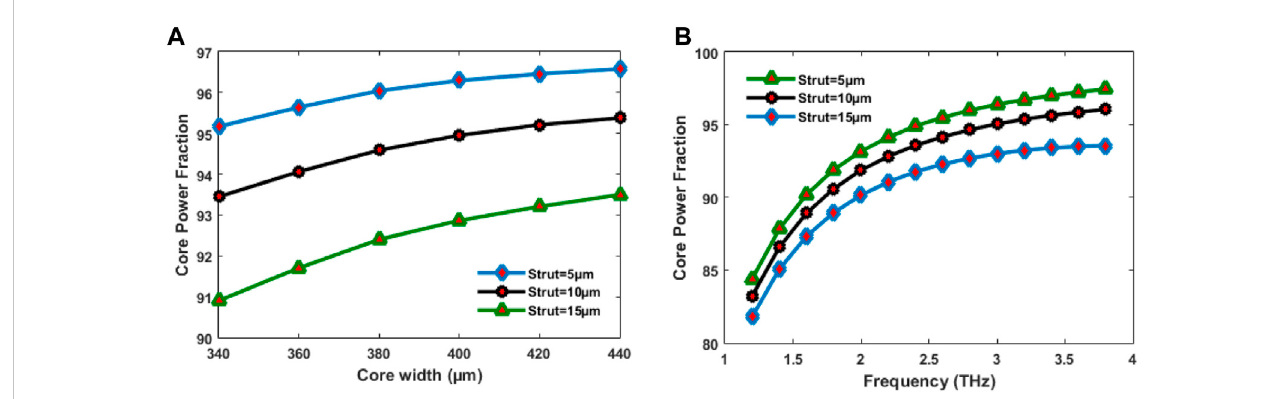
Relation of core power fraction with respect to core width and operating frequency. (A) Core power fraction vs. core width. (B) Core power fraction vs. operating frequency.